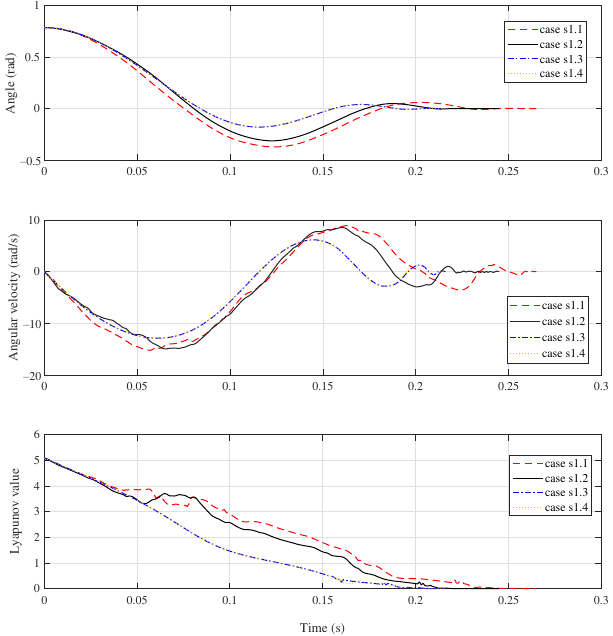
Figure 4. System response of Group s1. The upper subfigure describes the angular trajectory of the manipulator, the middle initial state ( q = 45 ◦ , ˙ q = 0) to the horizontal position ( q = 0, ˙ q = 0) in a very